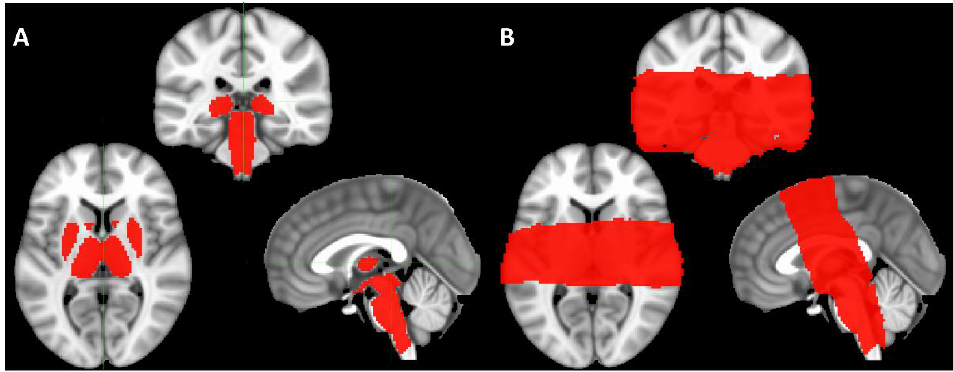
Figure 1. Spatial masks employed in the masked Independent Component Analyses. ( A ) Subcortical mask, including only the brainstem and subcortical nuclei; ( B ) Global mask, comprising the whole field of view.